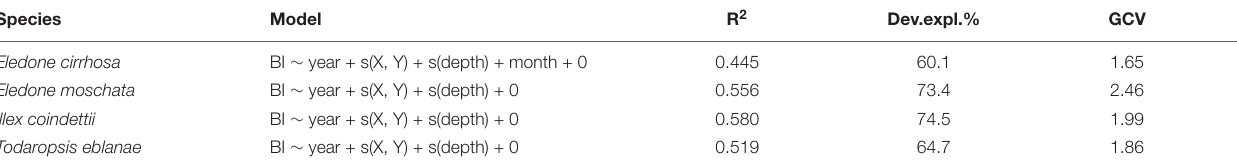
TABLE 2 | Selected GAM models with the predictive variables used for the standardization of the surveys indices. Species Model R